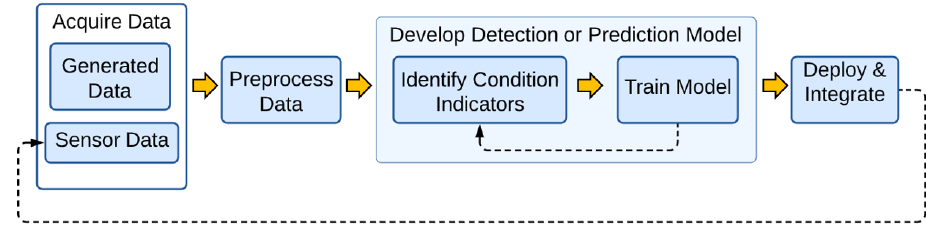
Figure 18. Data processing workflow of the preload prediction system.